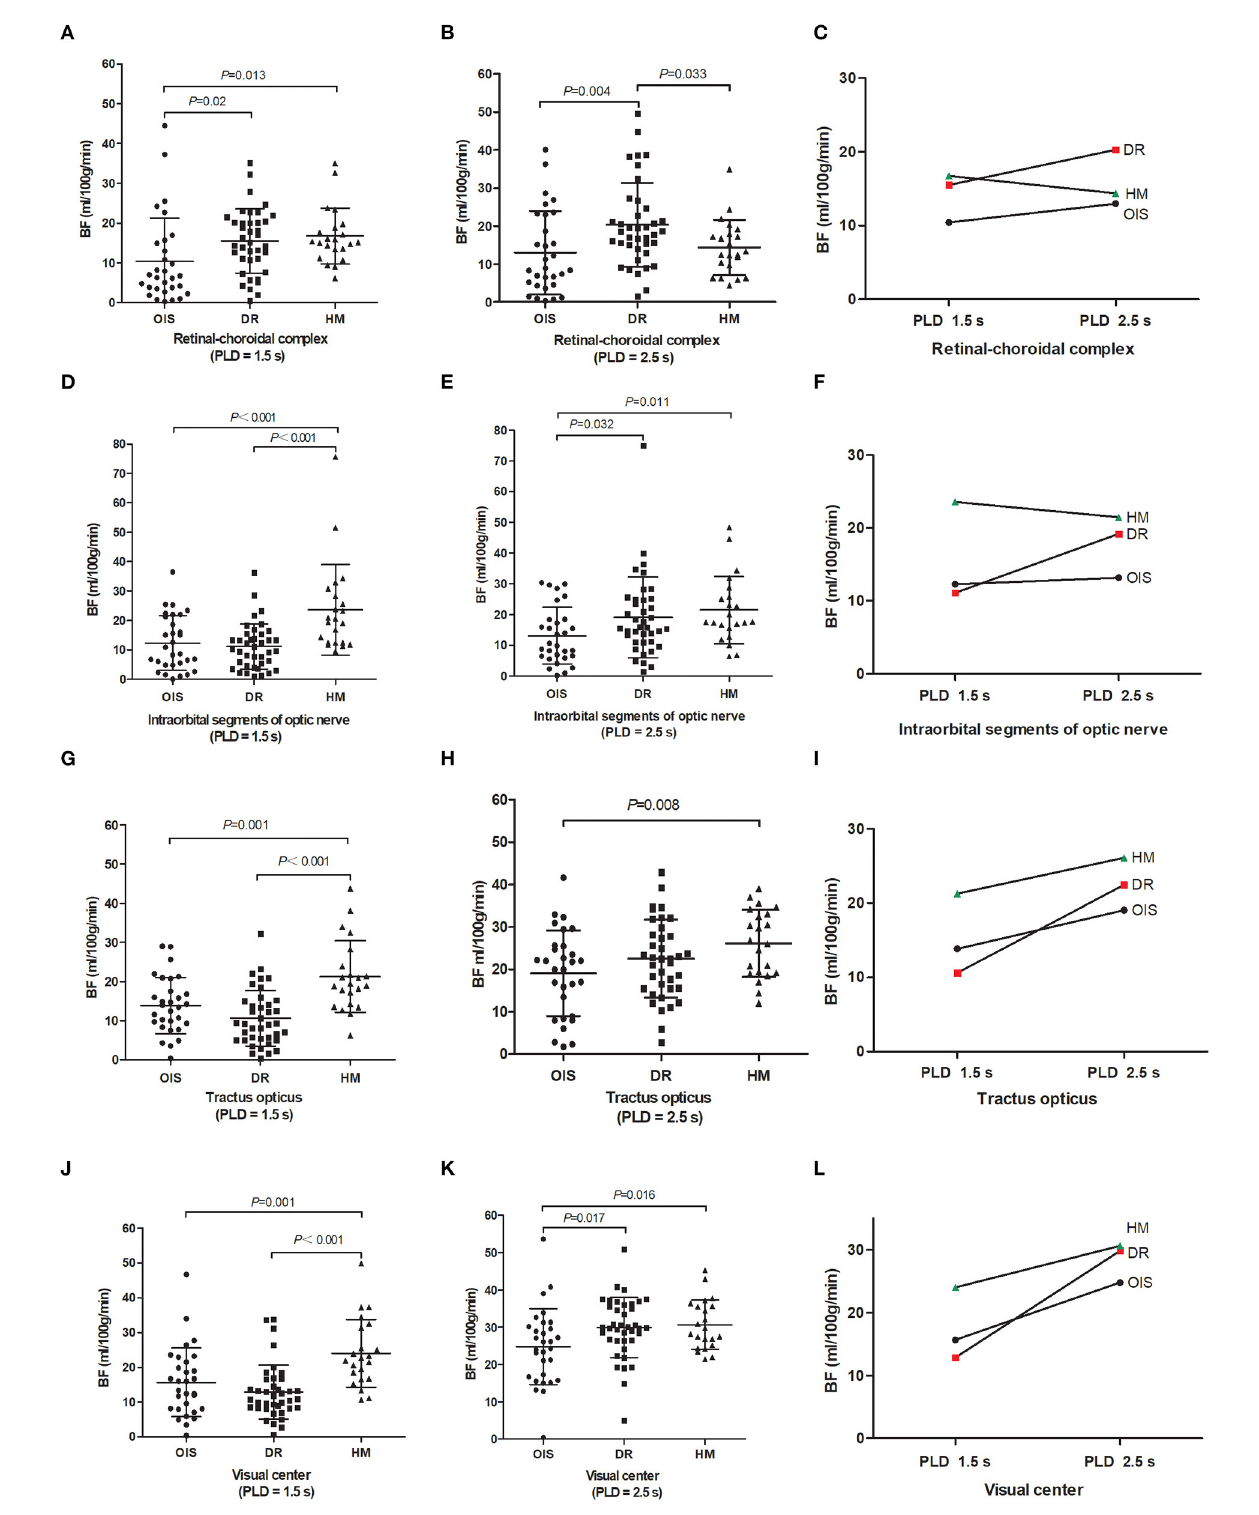
FIGURE3 Between-group comparison. Magnetic resonance imaging metrics for each subject are shown as raw data with lines for mean and standard deviation (A, B, D, E, G, H, J, K) . Images showing blood flow perfusion values changed from PLD 1.5–2.5s (C, F, I, L) . BF, blood flow; PLD, post-labeling delay; OIS, ocular ischemic syndrome; DR, diabetic retinopathy; HM, high